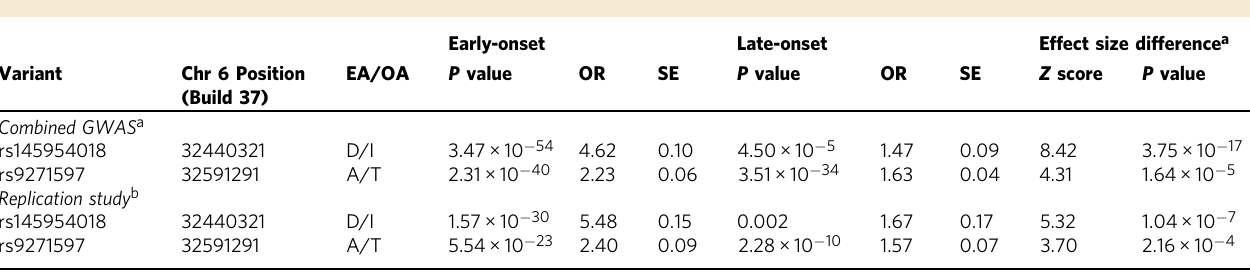
Table 1 Principal MHC class II variants in the early- and late-onset subgroups